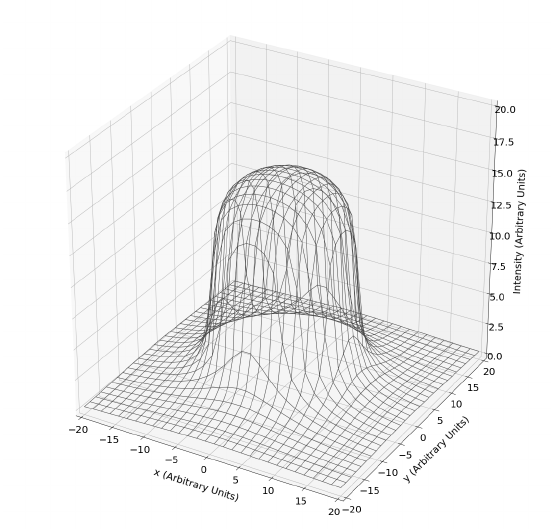
Figure 1. Example of a task Indicator distribution. The task is centered at the origin with an arbitrary radius. The intensity profile ( z -axis) is represented in arbitrary units. It is evident that the intensity is non-zero everywhere in the field, with a radical increase near the edge of the circular